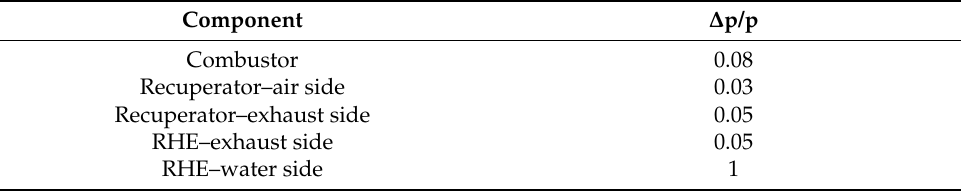
Table 1. Normalized pressure loss at the design point.